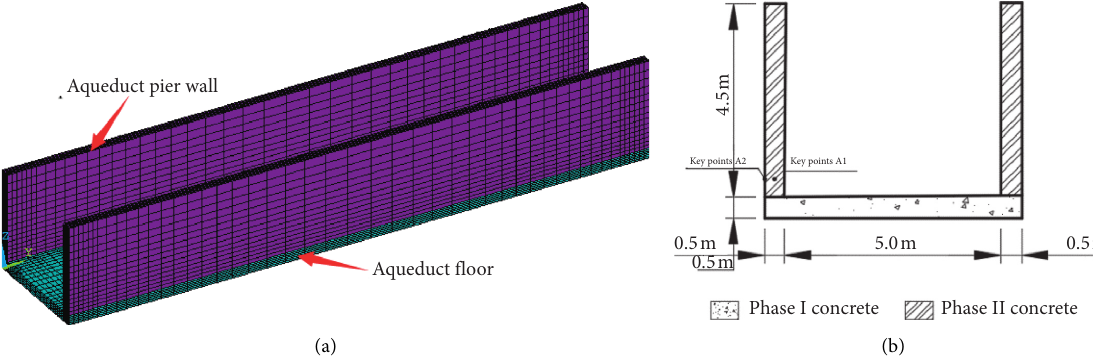
Figure 2: Finite element model and section size of aqueduct.